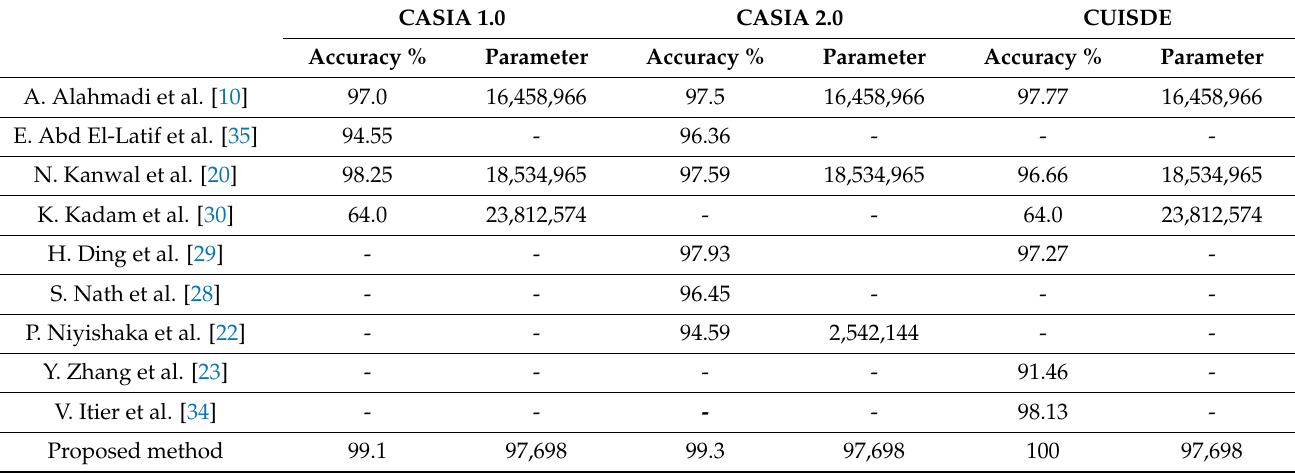
Table 7. A comparison of accuracy and number of parameters in the case of the proposed model and other recently published approaches over the CASIA 1.0, CASIA 1.0, and CUISDE dataset. CASIA 1.0